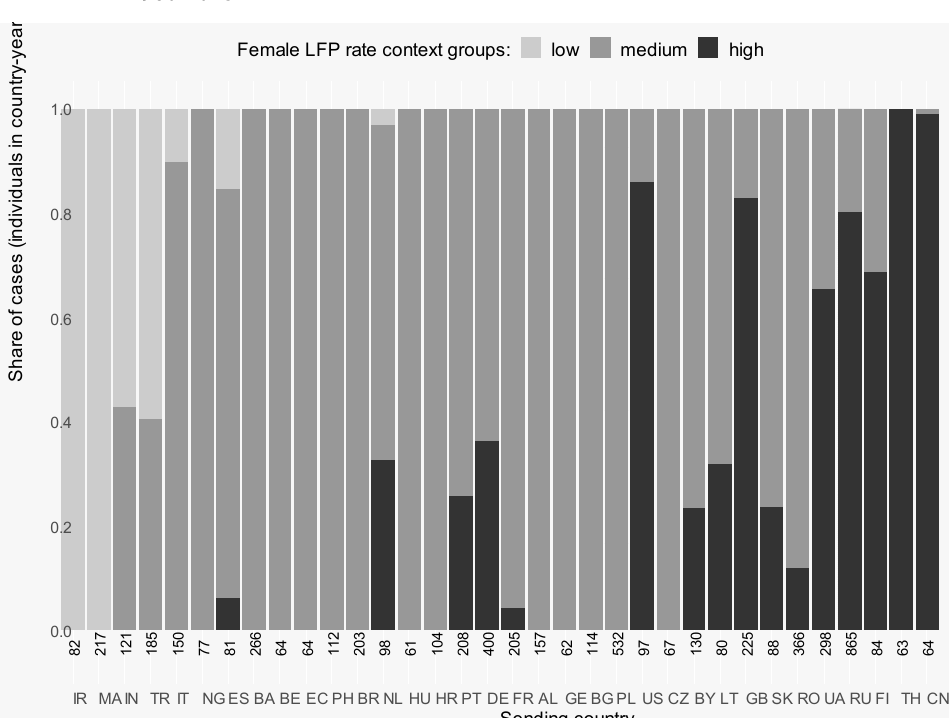
Figure 2 : Belonging to context groups of female LFP for the major sending countries,